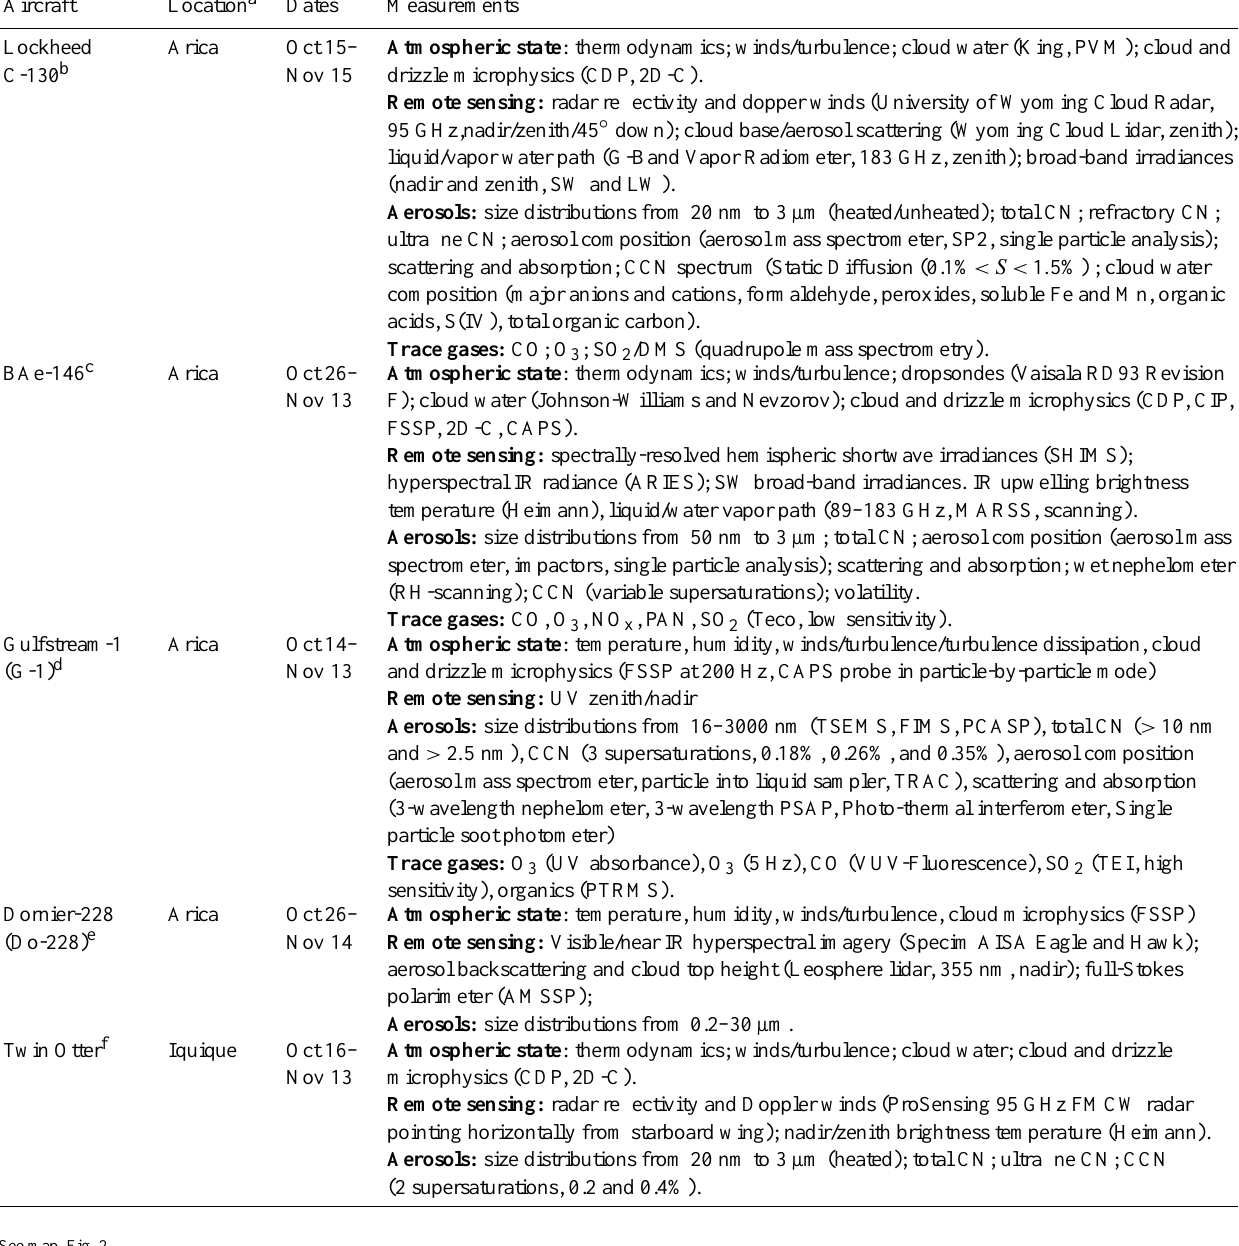
Table 2. Details of the aircraft used in VOCALS-REx.